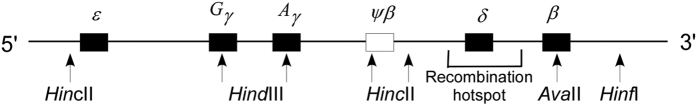
The location of the polymorphic restriction enzyme sites in the β-globin gene cluster.